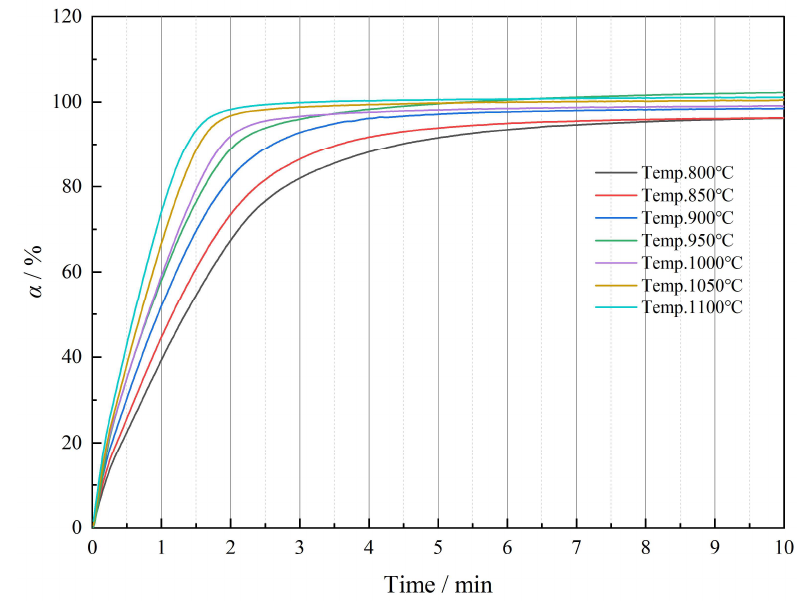
Figure 4. Reduction degree ( α ) of sample in H 2 atmosphere at 800–1100 ◦ C. The reduction rates d α / dt (min − 1 ) of iron ore fines at 800–1100 ◦ C were calculated from the reduction degree vs. time curve (Figure 5a), and the relationship between the initial (0–30%) and final (80–90%) reduction rate (Figure 5b). It has been shown that the reduction of iron ore fines is a complex multi-step reaction, which is the result of multiple couplings of chemical and structural changes. The theoretical reduction degree of the Fe 2 O 3 (Fe 2 O 3 → Fe 3 O 4 ) and Fe 3 O 4 (Fe 3 O 4 → FeO) is fixed at 0.11 and 0.33, respectively. The reduction rate in the initial and final stages gradually increased with increasing temperature, which is consistent with the basic principles of chemical kinetics and diffusion